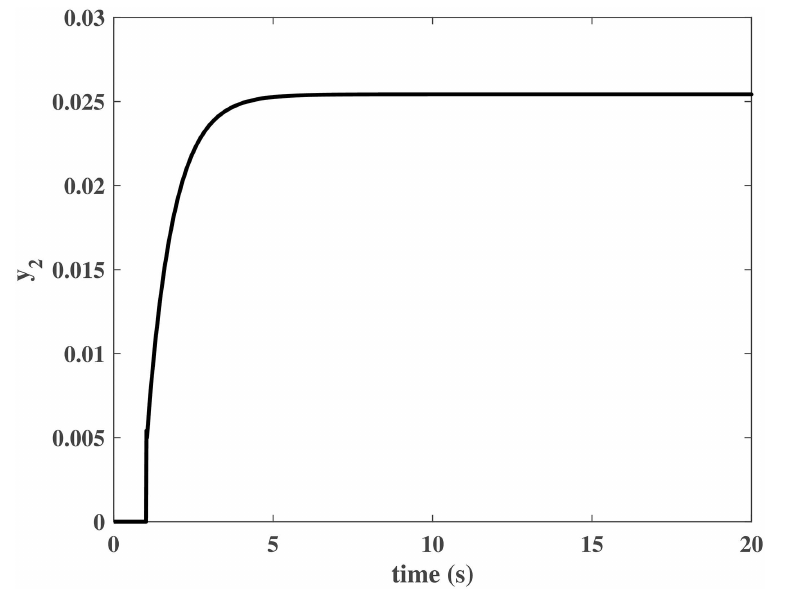
Fig 7. Response of y 2 in the numerical simulation.